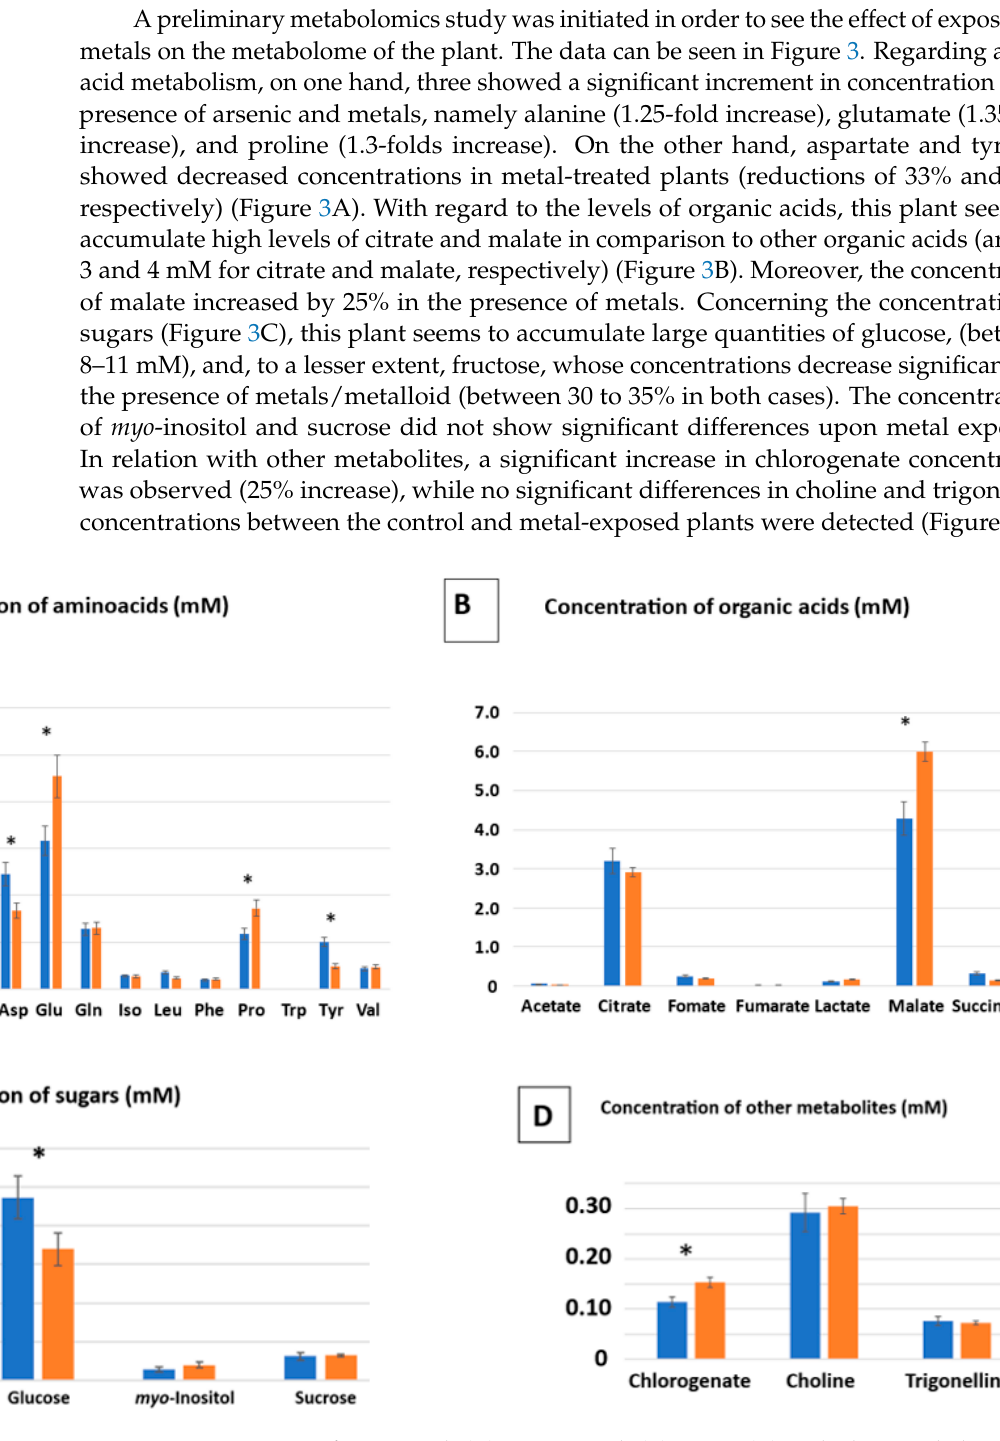
Figure 3. Concentration of amino acids ( A ), organic acids ( B ), sugars ( C ), and other metabolites ( D ) in the leaves of Mesembryanthemum crystallinum in the absence of metals (blue bars) and in the presence of a mixture of arsenic and metals (10 µM As + 1 µM Cd + 20 µM Cu + 50 µM Zn) (orange bars). Data are means ± standard deviations of three independent determinations. Statistically significant differences with regard to the control plants in the absence of metals are indicated by asterisks.